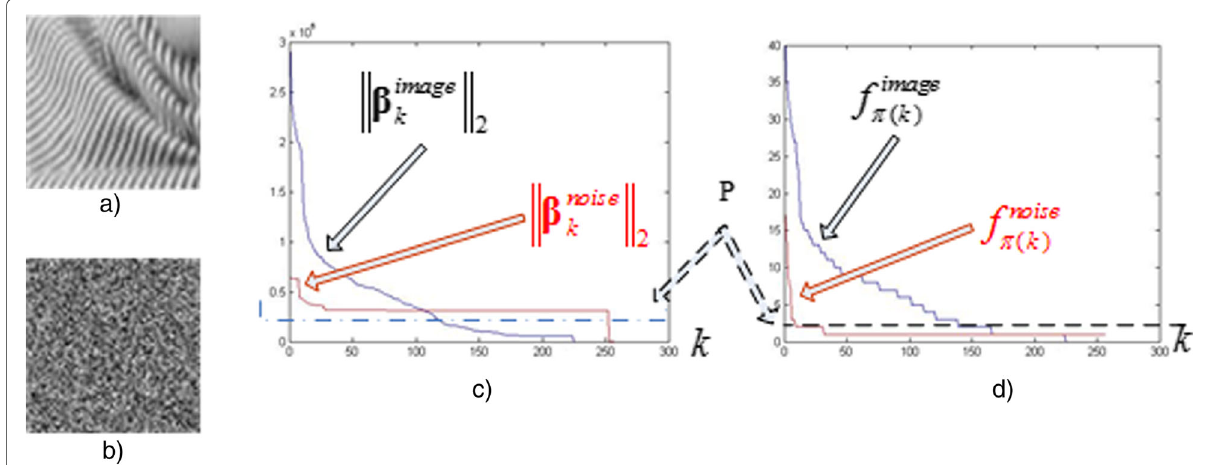
Fig. 1 Sparse signal subspaces with criterion of atom’s frequency. a Image with details. b White noise. c (cid:6) 2 -norm of β k . d (cid:6) 0 -norm of β